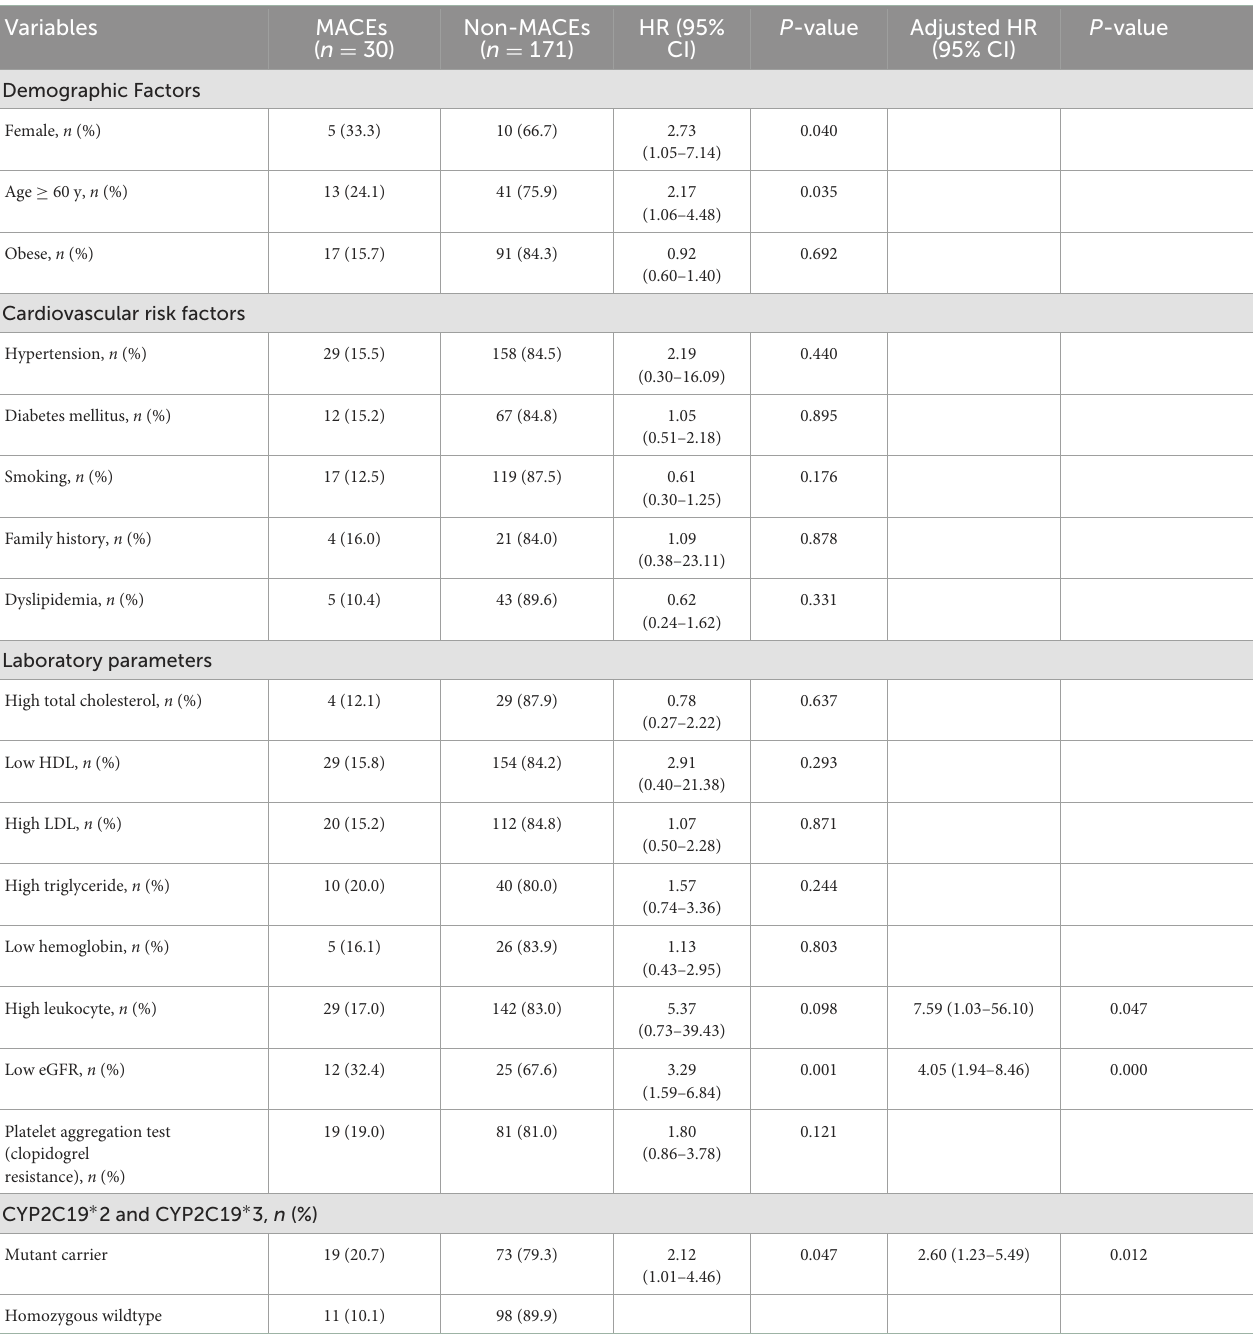
TABLE 5 The association between several factors and MACEs in 1